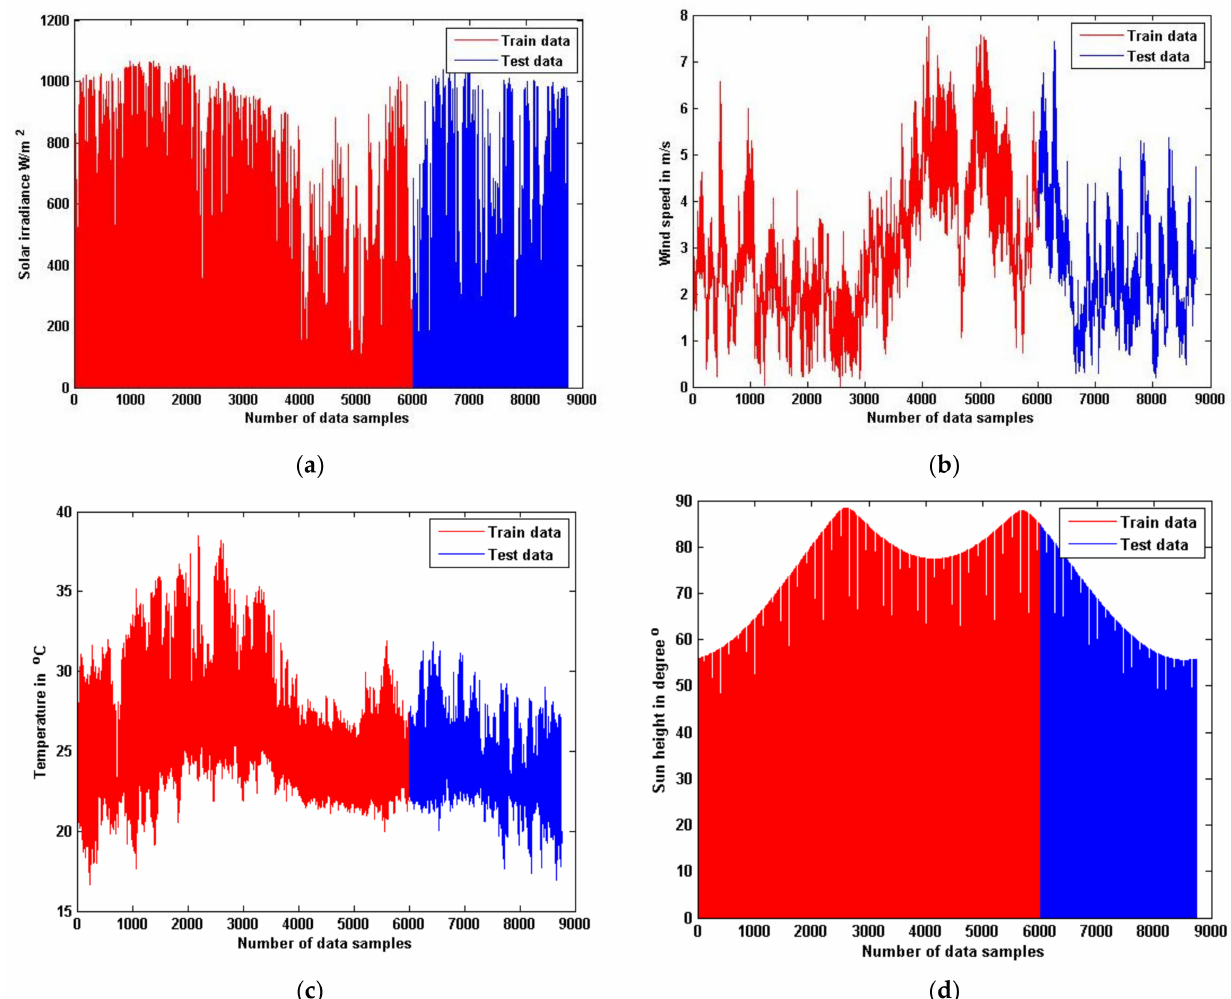
Figure 1. Training and testing sample dataset of environmental parameters: ( a ) Solar radiation; ( b ) Wind speed; ( c ) Ambient temperature of the location; ( d ) Sun